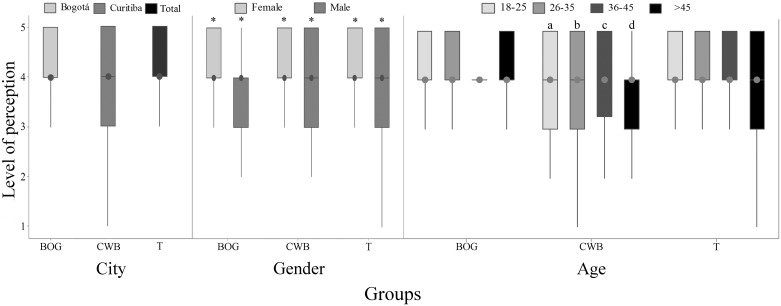
Perception of fish sentience (Q1) by 782 citizens of Bogotá and Curitiba, 2014/2015.Data for city, gender and age; 1 = certainly not and 5 = certainly yes; (BOG) represents data from Bogotá, (CWB) data from Curitiba and (T) the total data; the asterisk indicates gender difference (P<0.05, Mann-Whitney); letters indicate differences between age groups (P<0.05, Kruskal-Wallis and Dunn Test).